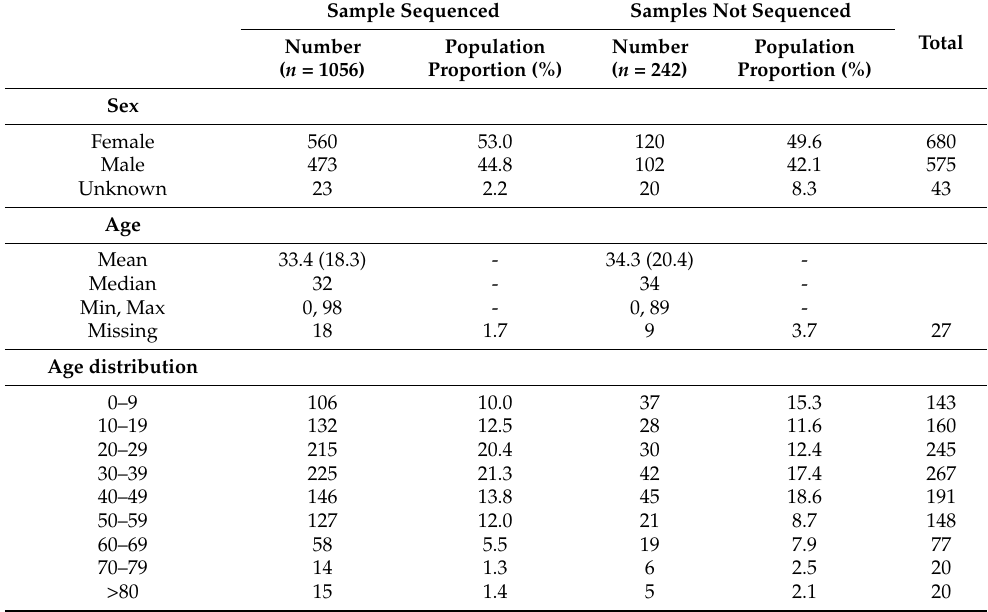
Table 1. Demographic characteristics of SARS-CoV-2 positive samples received for sequencing at KWTRP. Sample were collected between 14 March 2020 and 31 December 2021 ( n =